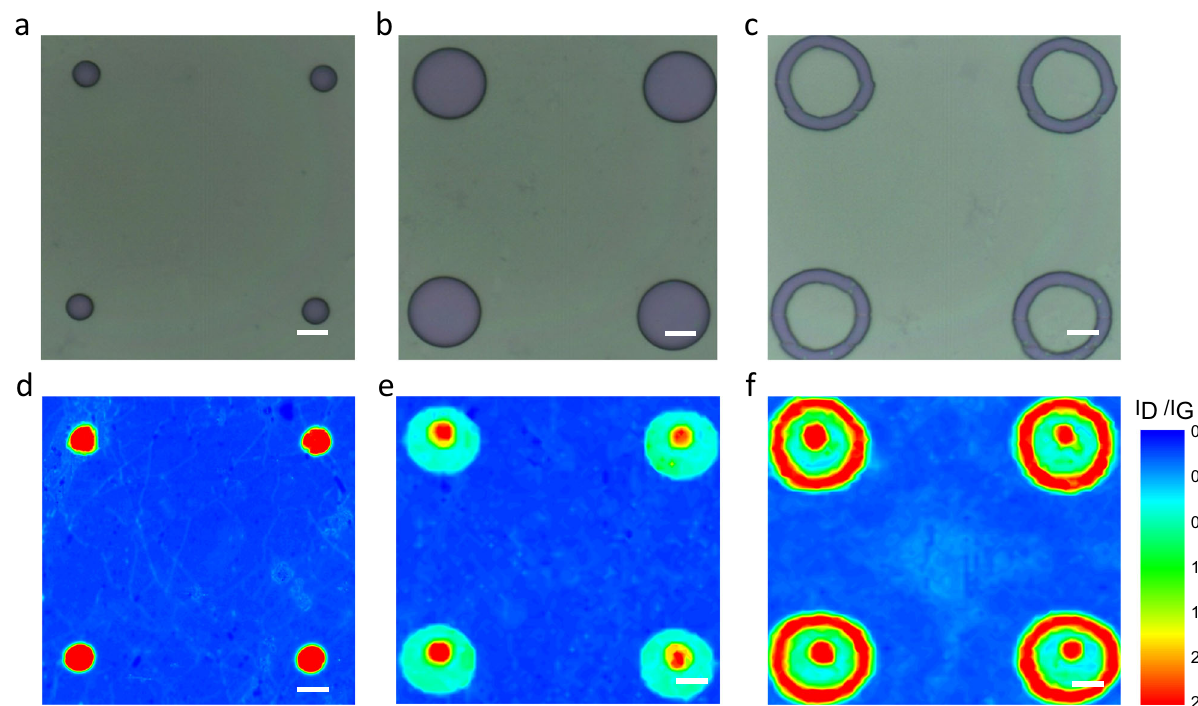
Fig. 3 Optical images of pattern and large-scale Raman I D / I G mapping. a, b, c Optical image of PMMA (polymethyl methacrylate) patterned graphene (precursor masks) for each step. The purple areas are the exposed graphene regions and the light green areas are covered by PMMA. d , e , f The corresponding Raman I D / I G mapping images after addend binding and removal of the PMMA layer. I D / I G : Raman D-band to G-band intensity ratio. The variations in color from blue to red in ( d , e , f ) represent the change in I D / I G ratio from 0 to 2.4. The red circles (exposed regions, zone I b ) and blue background (covered regions, zone V) in ( d ) denote the I D / I G ratios are 2.4 and 0, respectively. The red circles (zone I b ), turquoise concentric rings (zone II b ), and blue background (zone V) in ( e ) denote I D / I G ratios are 2.4, 0.7, and 0, respectively. The red circles (zone I b ), turquoise concentric rings (zone II b ), red concentric rings (zone III b ), and blue background (zone V) denote I D / I G ratios are 2.4, 0.7, 2.4, and 0, respectively. Scale bar = 5 µ